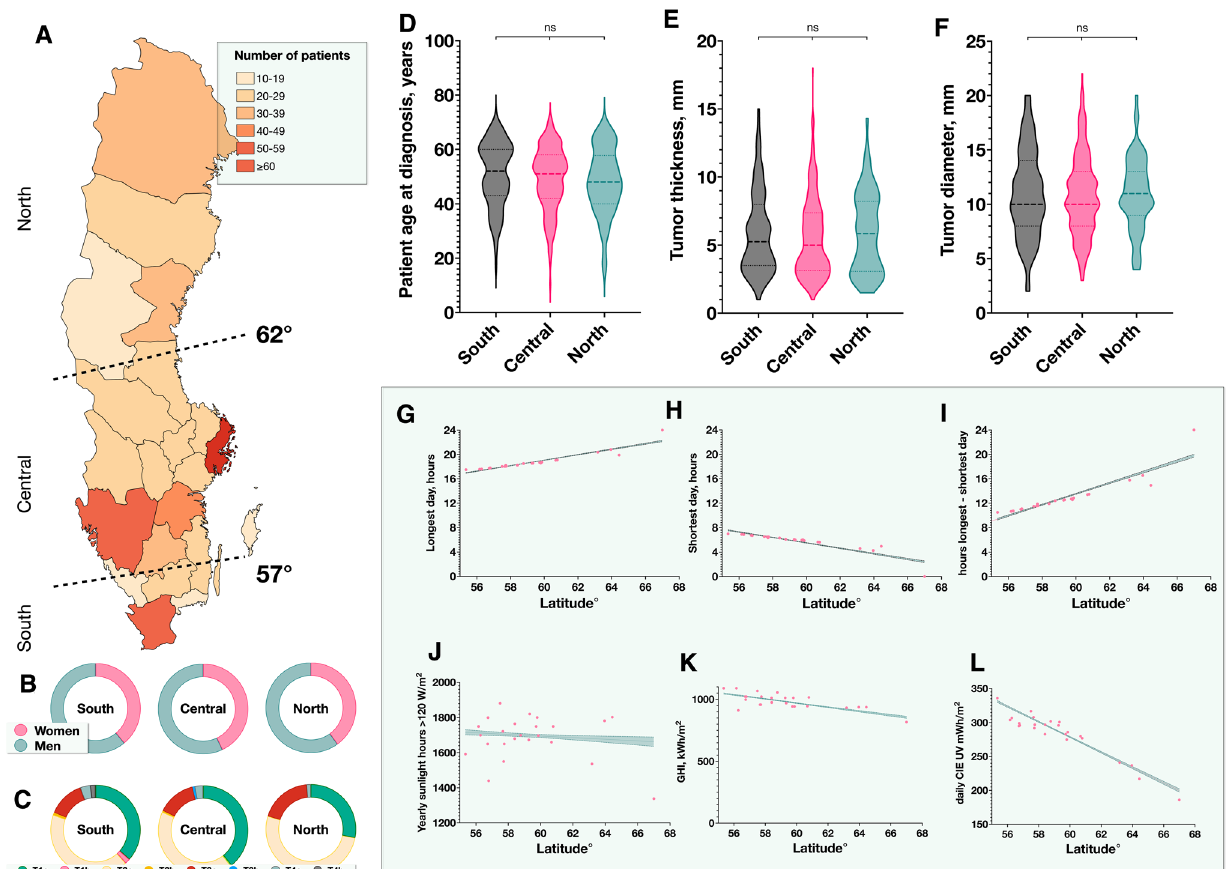
Fig. 1 Characteristics of patients, tumors and sunlight intensity across regions and latitudes. A Number of patients born in the southern, central, and northern regions and individual counties. B The distribution of patient sex was similar in all three regions ( χ 2 P = 0.66). C Simi- larly, there were no significant differences in distribution of AJCC T-categories across the regions ( χ 2 P = 0.48). D to F There were no signifi- cant differences in patient age at diagnosis (Kruskal–Wallis P = 0.21), tumor thickness ( P = 0.39) or tumor diameter ( P = 0.86) across the three regions. G The duration of the longest day in a year increased with a slope coefficient of 0.45 h per degree of latitude (R 2 = 0.86, P < 0.001). H The duration of the shortest day in a year decreased with a slope coefficient of − 0.44 h per degree of latitude (R 2 = 0.78, P < 0.001). I Conse- quently, the difference between the longest and shortest day in a year increased with latitude (R 2 = 0.82, P < 0.001). J The annual hours with an intensity of > 120 W/m 2 decreased with 5 h/year per degree of latitude (R 2 = 0.01, P = 0.005). k Similarly, the GHI decreased with 16 kWh/ m 2 per increasing degree of latitude (R 2 = 0.58, P < 0.001). L The average daily CIE UV decreased with -11 mWh/m 2 per increasing degree of latitude (R 2 = 0.87, P < 0.001). AJCC American Joint Committee on Cancer, ns non-significant, GHI annual global horizontal irradiance, UV ultraviolet light, CIE UV CIE (International Commission on Illumination)-weighted UV